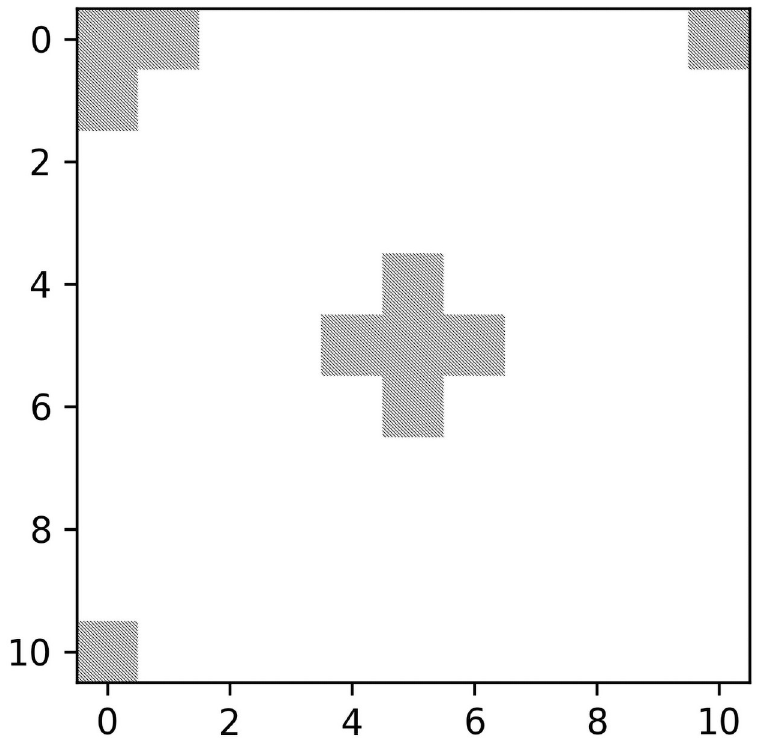
Fig 2. Demonstration of a toroidal environment. A set of five non-empty resource entries in a cross formation is centered at entry e 0,0 and then translated to e 5,5 on a 11 × 11 toroidal matrix environment.